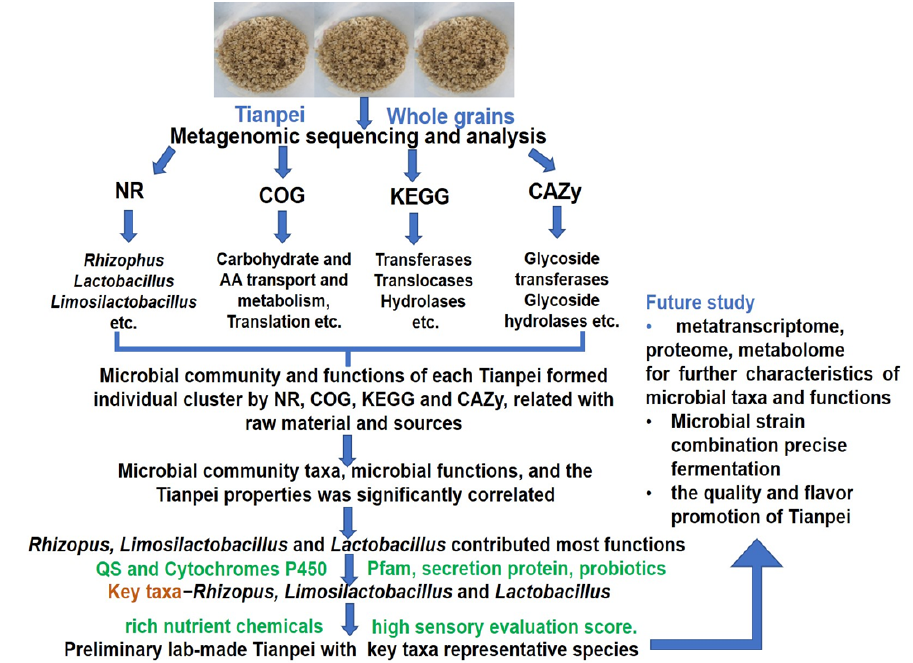
Figure 5. The summary of the research ideas, process, main results, and future study.